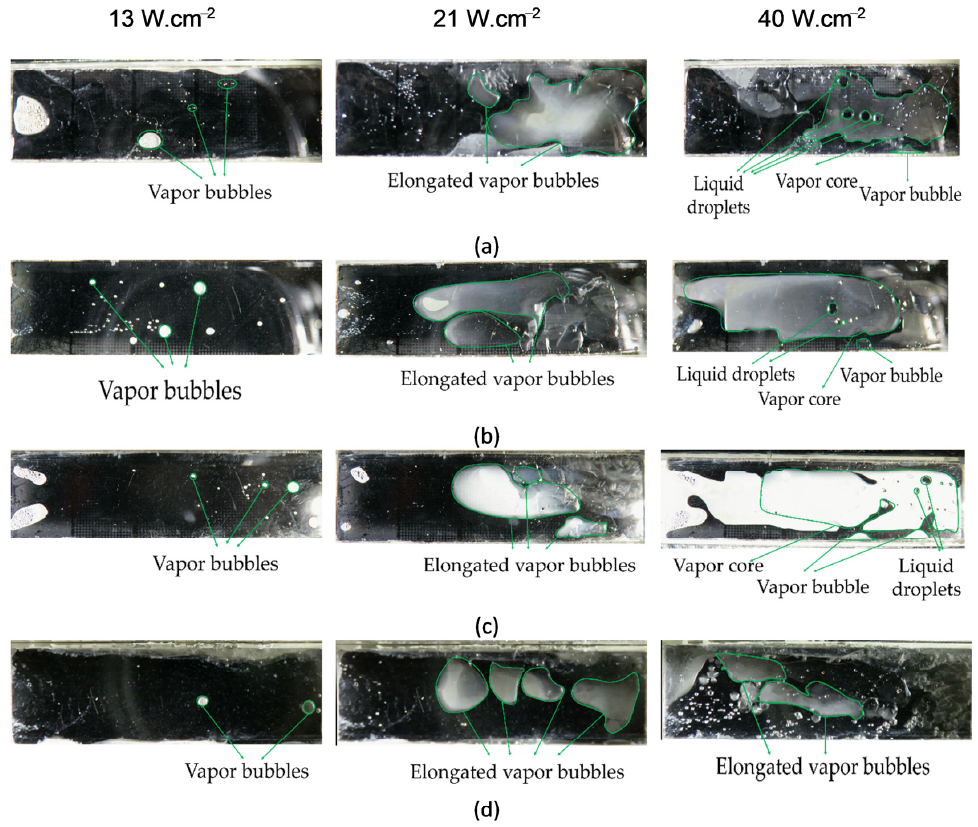
Figure 10. Flow patterns on tested sample at three different heat fluxes ( a ) sample #1, ( b ) sample #2, ( c ) sample #3 and ( d ) wholly hydrophobic surface.